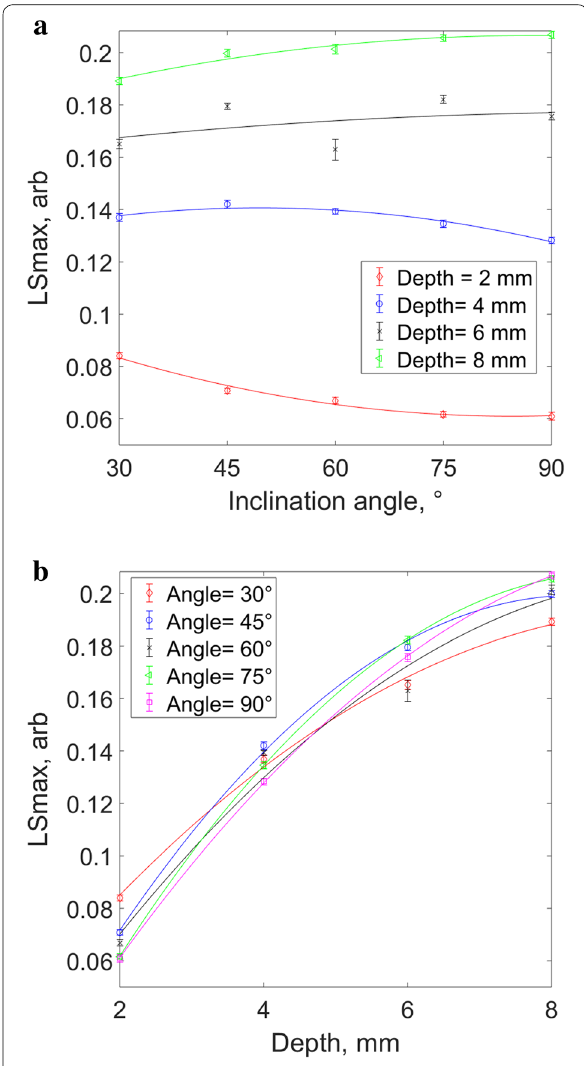
Figure 7 Correlation of LS max with ( a ) inclination angle, at different depths and ( b ) depth, at different inclination